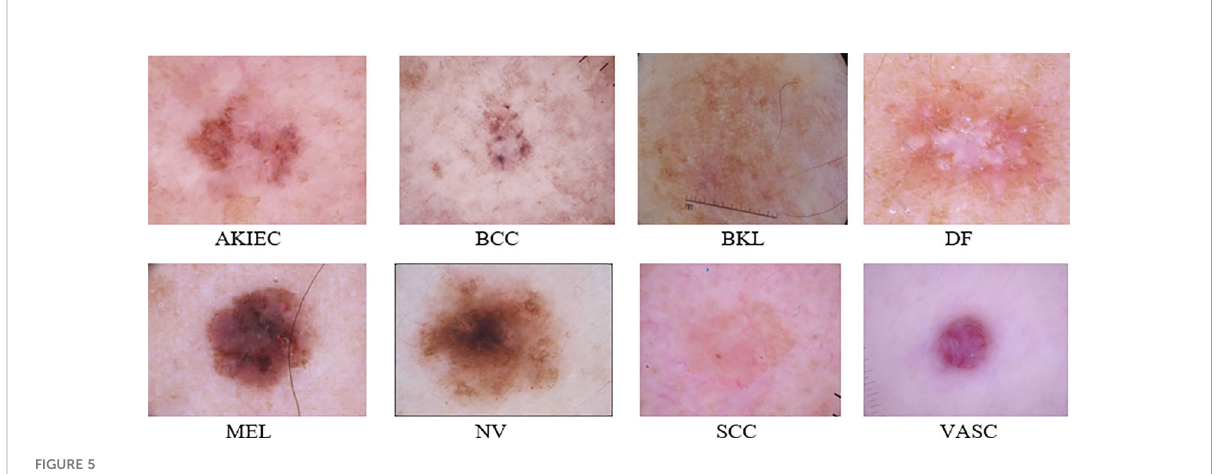
FIGURE 5 An example of the ISIC 2019 dataset categories is shown.